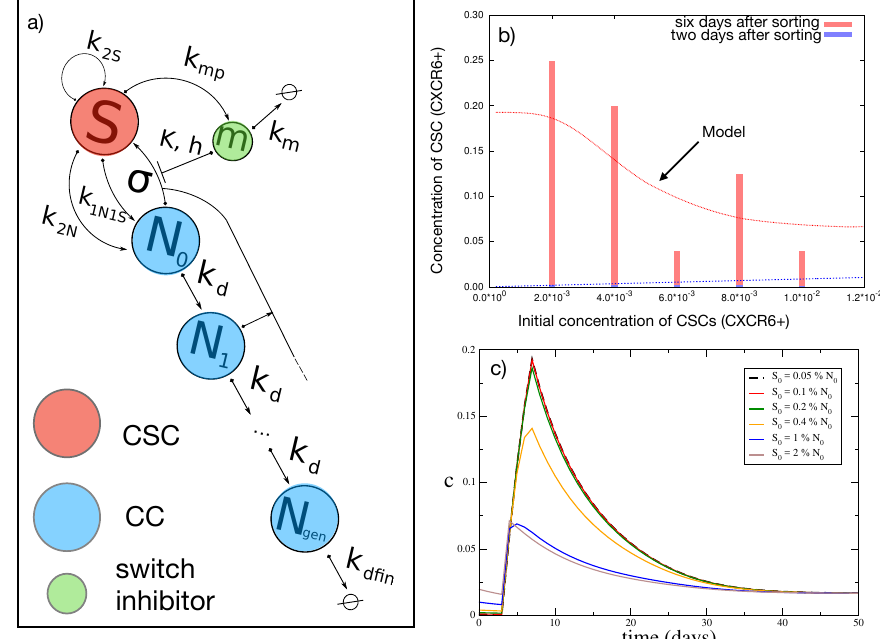
Figure 1. Mean-field model ( a ) Reaction network for the mean-field model, involving cancer stem cells (CSCs) ( S ), cancer cells (CCs) ( N j ) and inhibitor molecule m . ( b ) The experimental fraction c ( t ) of CSCs after 2 days (blue bars) and after 6 days (red bars) from their sort out, as a function of their remaining fraction c ( 0 ) . The curves indicate the simulated results. ( c ) The dynamics of the concentration c ( t ) of CSCs with different choices of the initial value c ( 0 ) ( N 0 = 10 6 , m 0 =